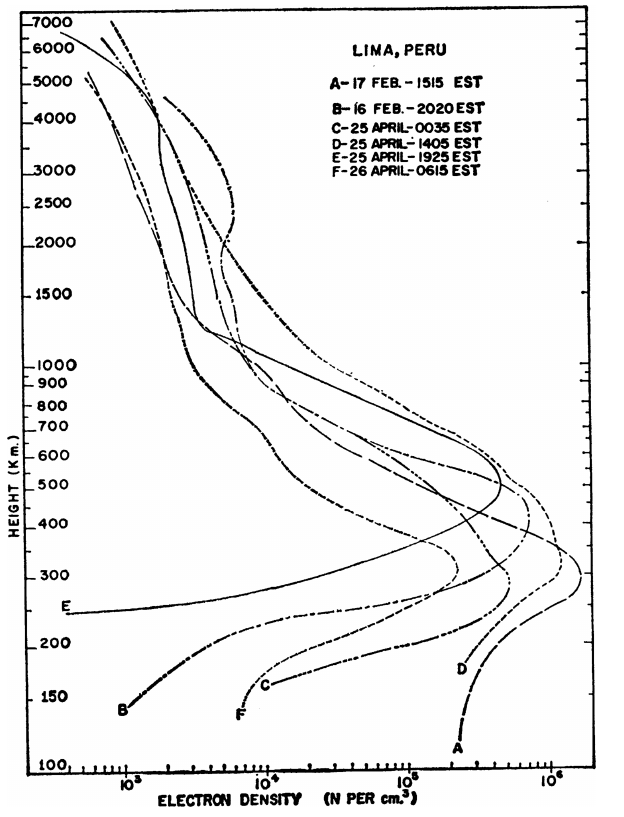
Figure 14. Composite of electron density profiles measured be- tween February and April 1962 (adapted from Bowles,